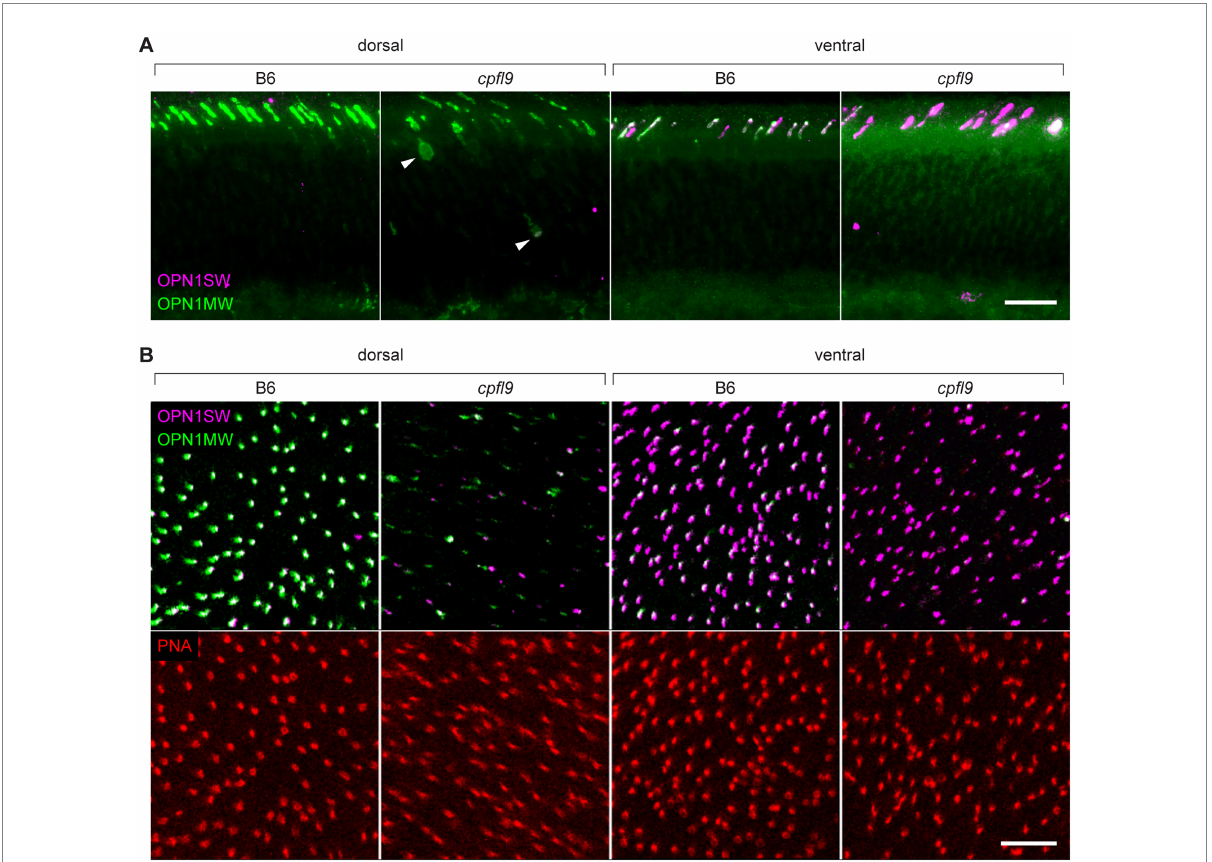
FIGURE 4 Immunostaining of cone opsins in cpfl9 mutants and B6 controls at 12 weeks of age. (A) Thin retinal sections stained with anti-OPN1MW (green) and anti-OPN1SW (magenta). In the dorsal retina, where expression of M cones is predominant, mislocalization of OPN1MW to the cone cell soma (arrowheads) and pedicles was observed. In the ventral retina, there was a significant reduction of OPN1MW expression in dual-expressing cones. (B) Stellaris confocal imaging of retinal flatmounts. Scale bars in A and B , 10 μ m. Images in A and B are representative of n = 4 cpfl9 and n = 6 B6